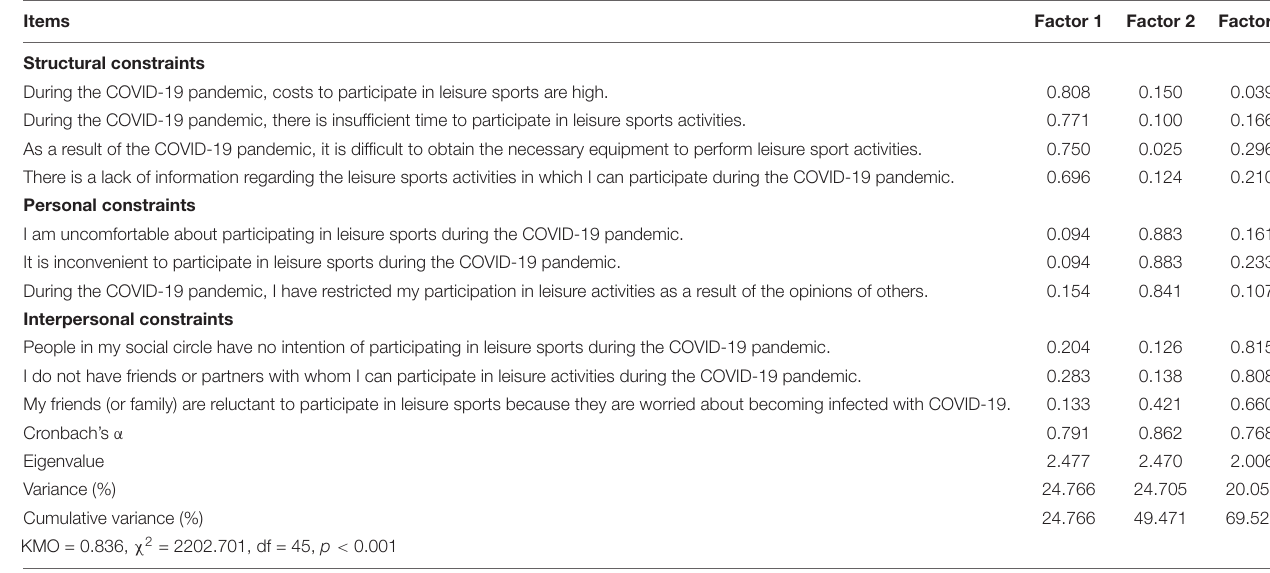
TABLE 2 | Results of the exploratory factor analysis of the Leisure Constraints Scale modified to reflect the COVID-19 pandemic situation.